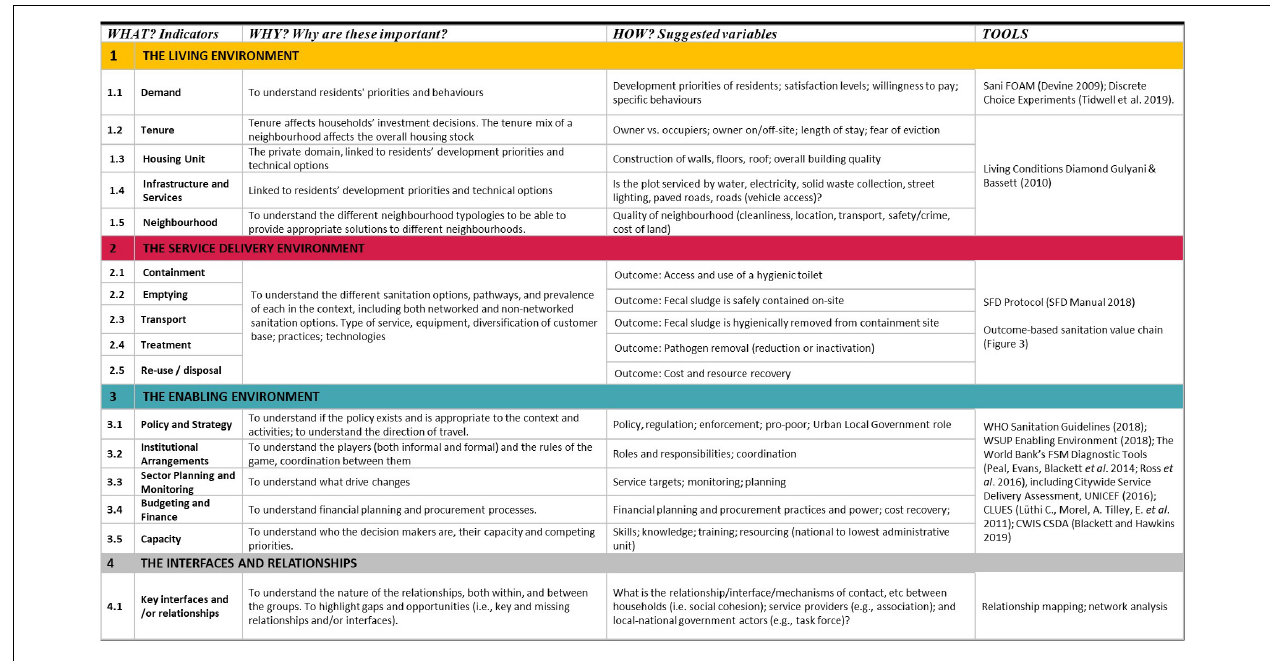
FIGURE 2 | Proposed Sanitation Cityscape indicators (WHO,